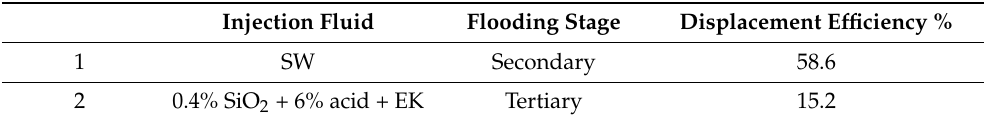
Table 12. Summary of CF5.